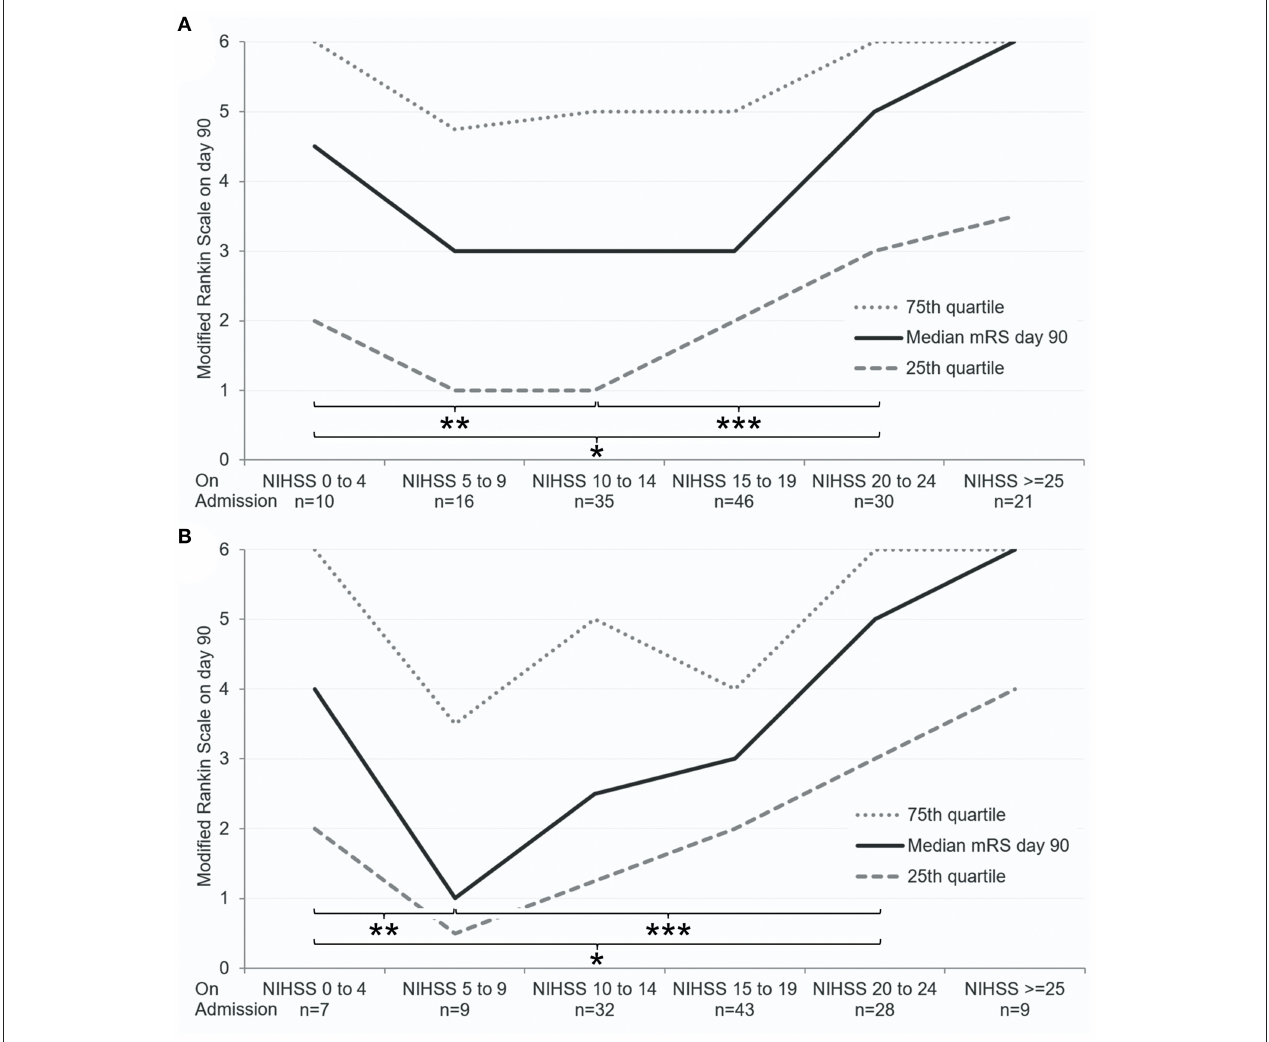
FIGURE 1 | Association of NIHSS on admission with functional outcome on day 90 in patients treated with MT. Only patients with baseline mRS 0–2 (during the week before admission) were included in this figure. (A) Including anterior and posterior circulation strokes ( n = 158). (B) Including only anterior circulation strokes (cohort of sensitivity analysis, n = 154; 26 patients did not have day 90 outcome data). Median mRS (black line) and 25th and 75th quartiles (dotted gray lines) are displayed. *** p < 0.05, ** p < 0.1, * p > 0.1 (Wilcoxon rank-sum test between indicated patient